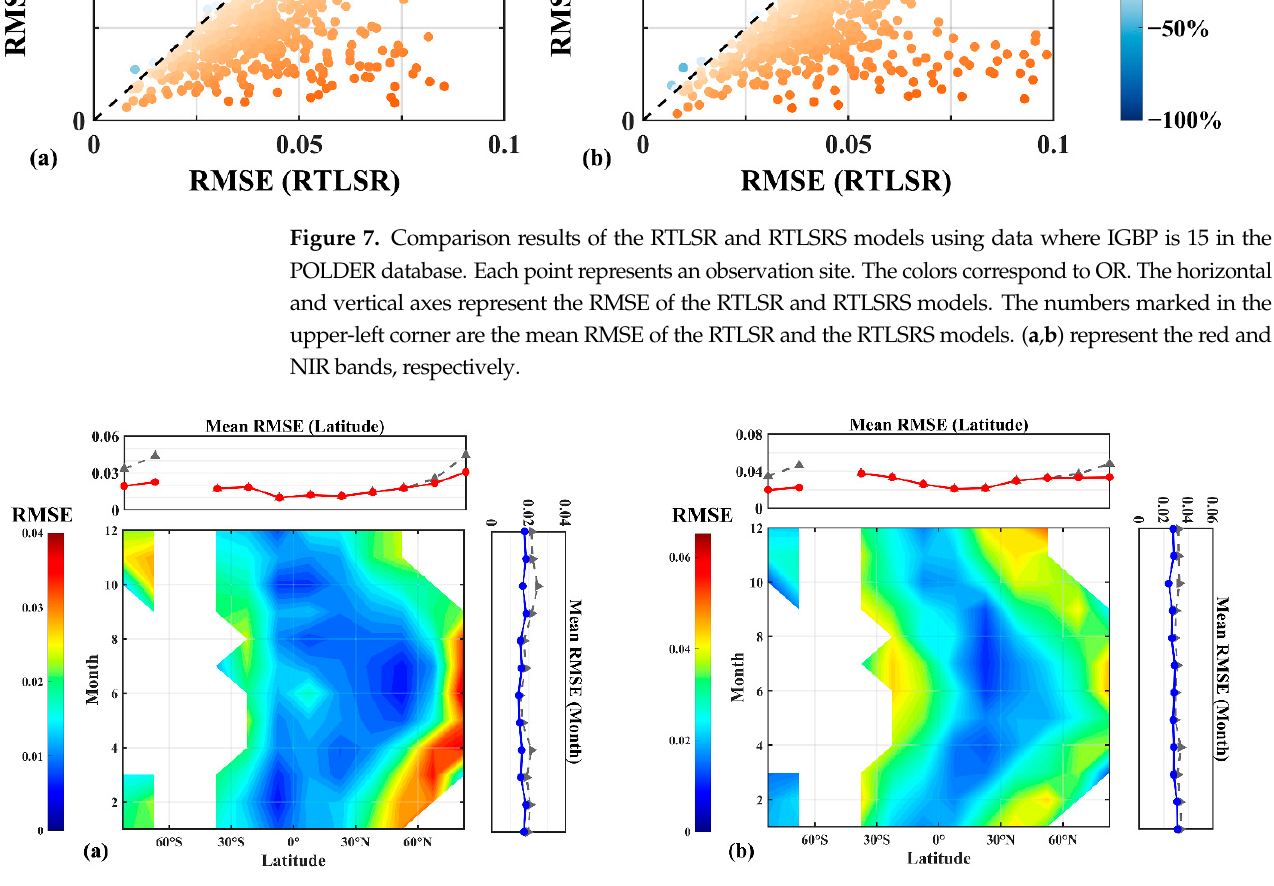
Figure 8. Comparison of the fitting residuals of the SJRS at different latitudes and months in the red ( a ) and NIR ( b ) bands. The colored bars represent RMSE values. The mean RMSE variation in different latitudes and months in the two bands are shown in the line plots above and to the right of the heatmaps, respectively. The gray lines in the line plots represent the mean RMSE of the RTLSR model, they are the same as the lines in Figure 5.